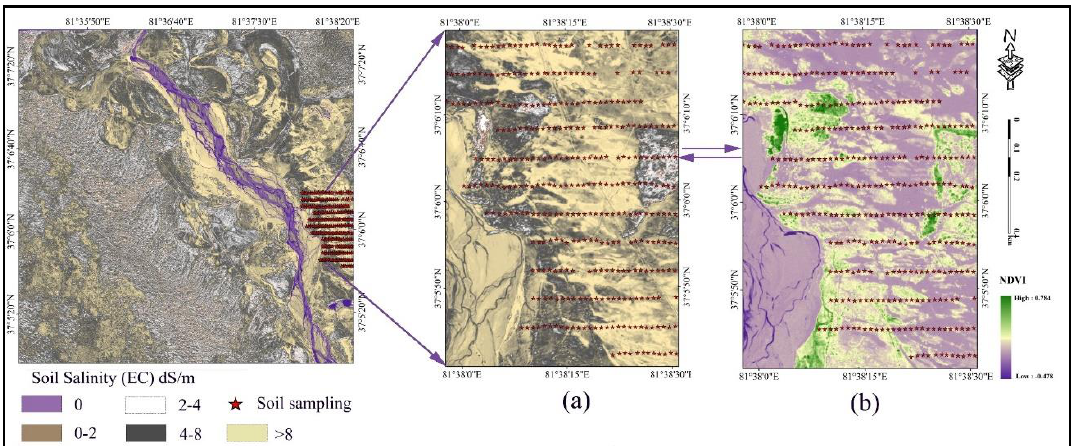
Figure 14. The soil salinity maps with EC data: ( a ) sampling area and EC inversion based on the optimal PLSR model and ( b ) sampling area based on Normalized Difference Vegetation Index (NDVI) inversion.